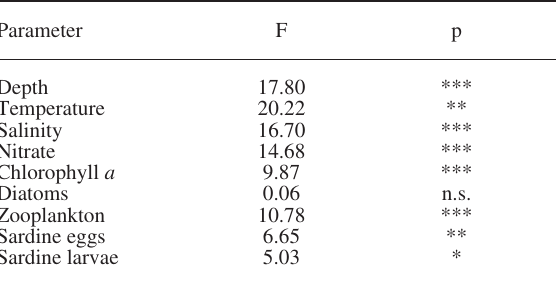
Table 3. – anoVa of environmental parameters and sardine eggs and larval abundance by group (Gi, Gii and Giii), f: